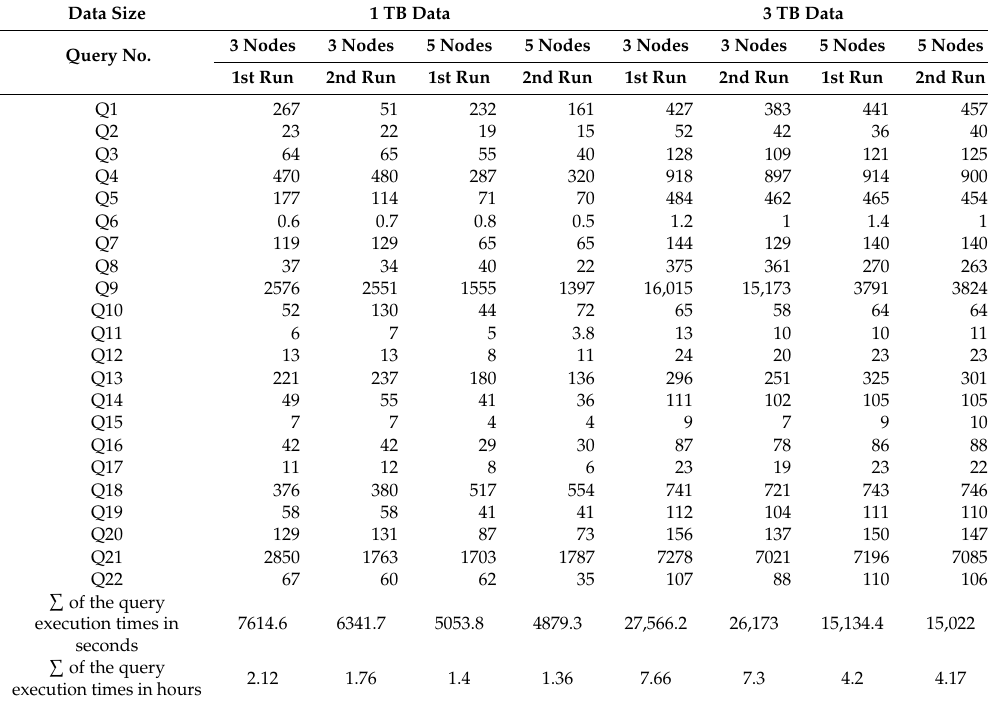
Table 3. TPC-H benchmark queries for 1 TB and 3 TB test database